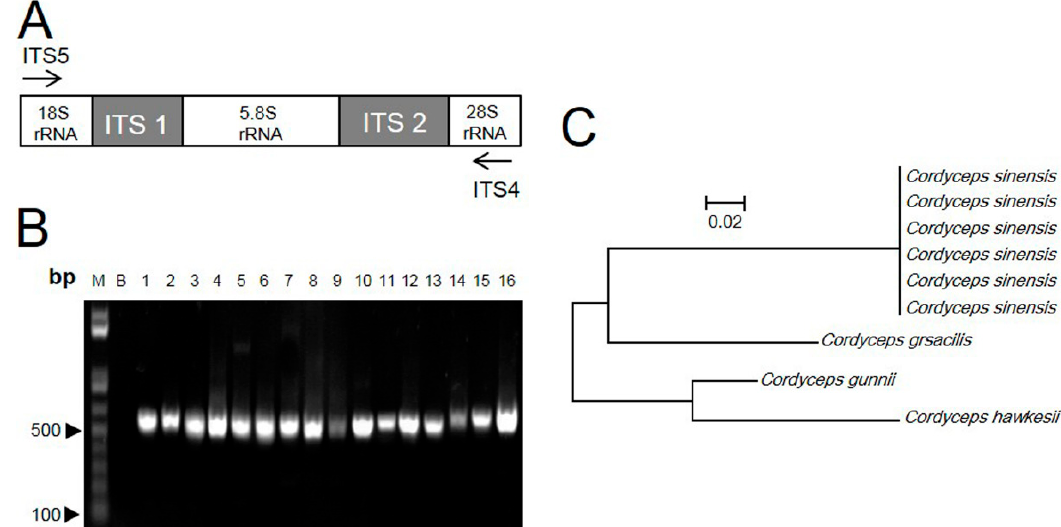
Figure 2. ITS sequence of Cordyceps. ( A ) ITS (internal transcribed spacer) regions and the primers, ITS4 and ITS5, for PCR are shown; ( B ) amplicons of Cordyceps and its adulterants with ITS primers. All samples produced a band at ~550 bp. n = 4; ( C ) The ITS sequences were identified and matched fully from sequences of GenBank, i.e. , C. sinensis (FJ481125), C. gracilis (AJ786565), C. hawkesii (GU453920) and C. gunnii (KJ021181). DNA sequences of ITS fragment from 16 samples were submitted to phylogenetic study by the maximum parsimony method.